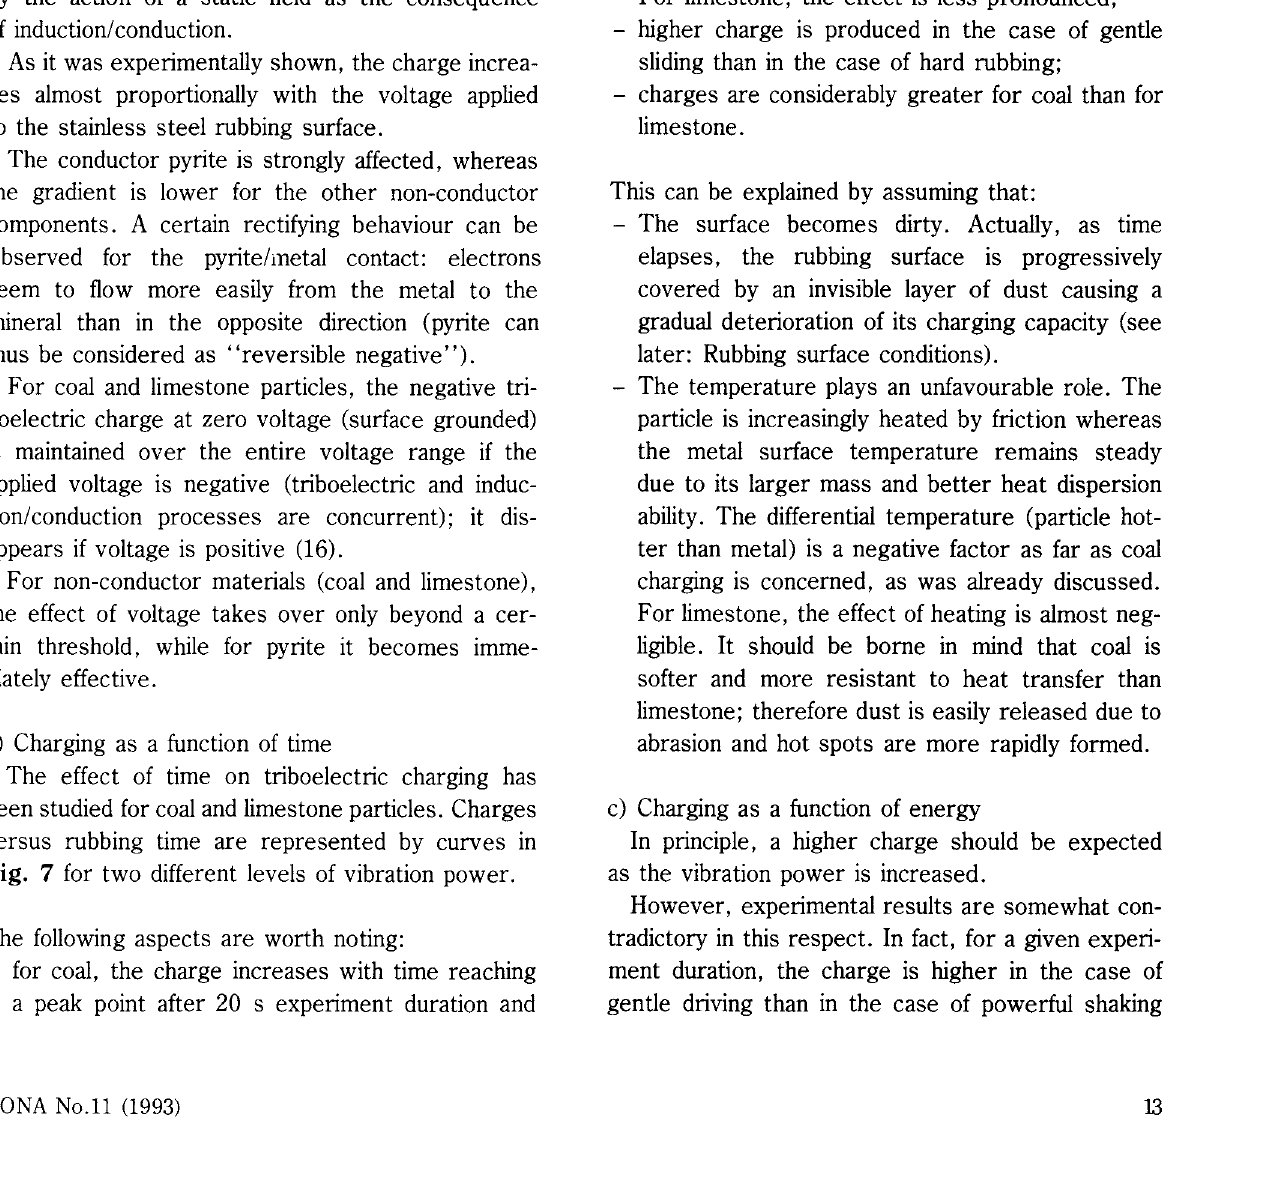
Fig. 7 Average particle charge as a function of rubbing time. 1-Coal, gentle sliding; 2- Coal, hard rubbing 3- Limestone, gentle sliding; 4- Limestone, hard